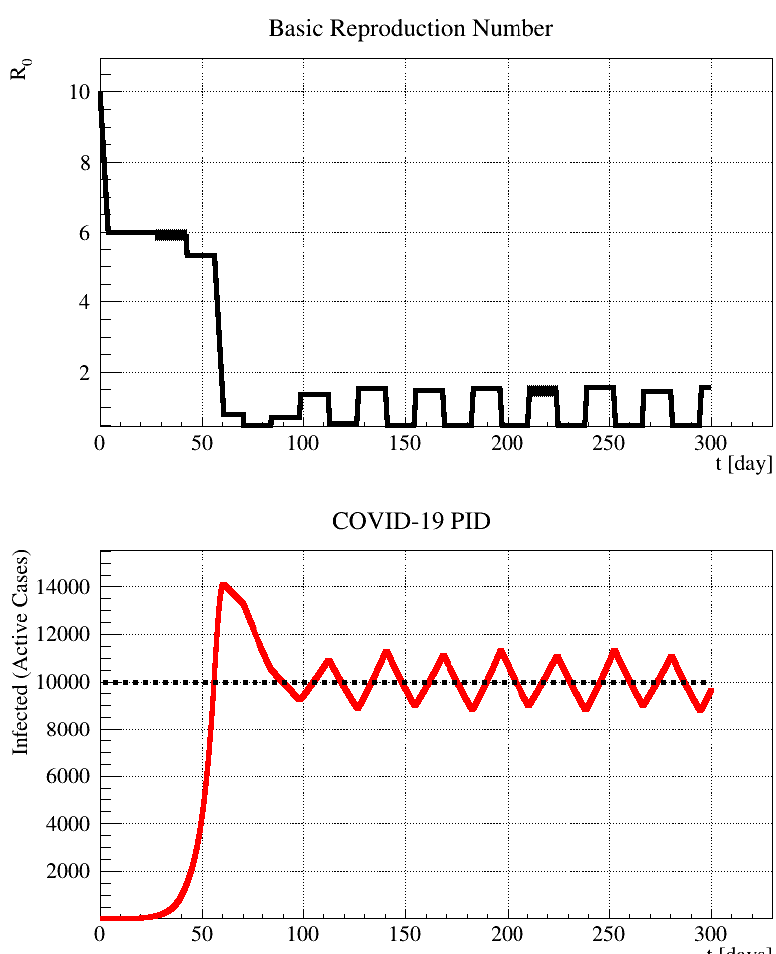
Figure 5. Example of PID controller simulation. Behaviour of ( top ) the input basic reproduction number, R 0 , and ( bottom ) the output number of the infectious individuals, I ( t ) , with K p = 5 and K i = K d = 0. The dashed black line represents the set-point. A mild proportional term avoids a strong overshoot at the first reach of the set-point but is not sufficient for damping the system oscillation. This corresponds to a less drastic social restriction at the beginning and then a subsequent attempt to stabilize the rate with the mild and strong